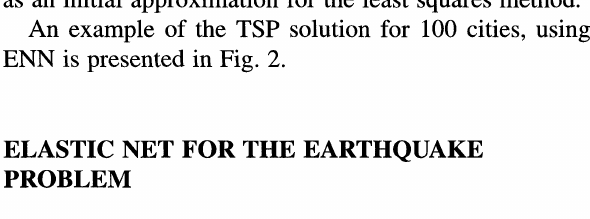
FIGURE 4 An evolution ofthe elastic net on a data from six correct and three noise seismic